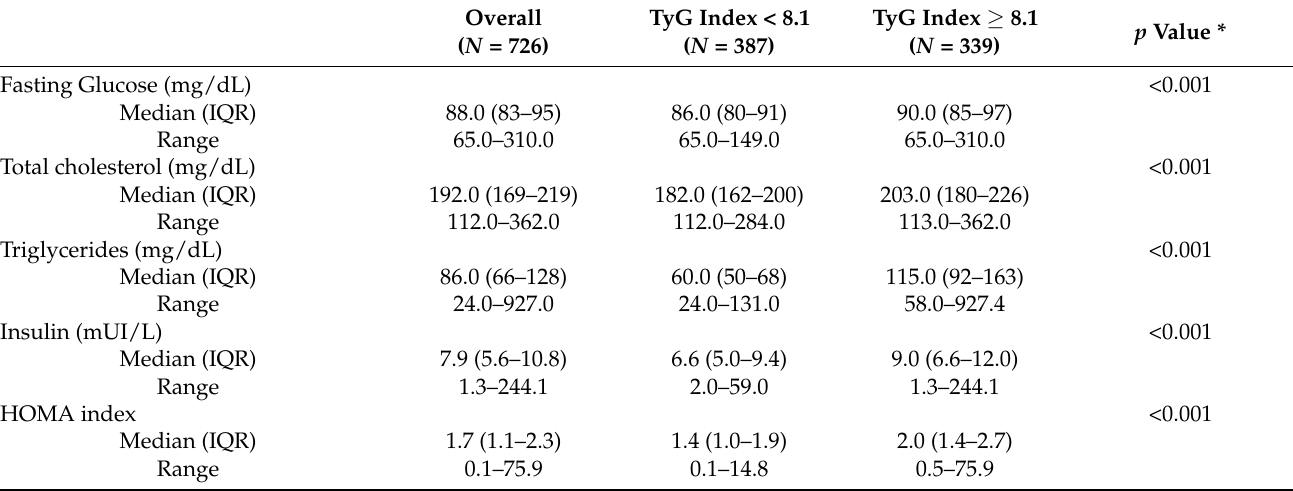
Table 2. Hormonal and metabolic of the study cohort according to TyG index suggesting insulin resistance ( N =